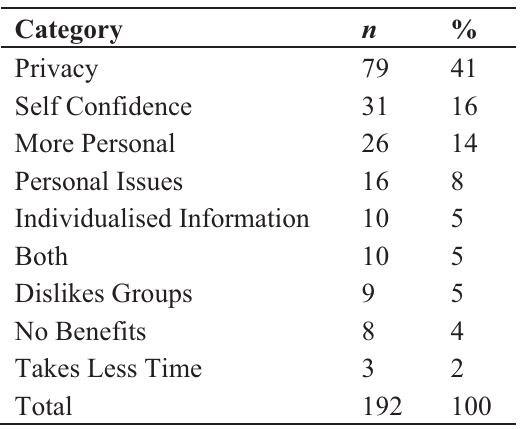
Table 5. Number and percentage of respondents giving various reasons for preferring individual appointments.